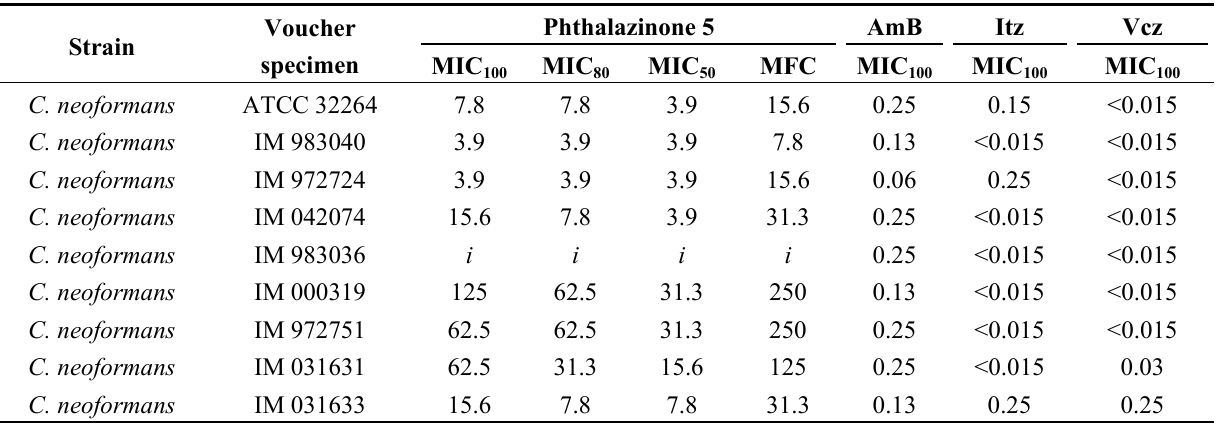
Table 3. Minimum Inhibitory Concentration (MIC) and Minimum Fungicidal